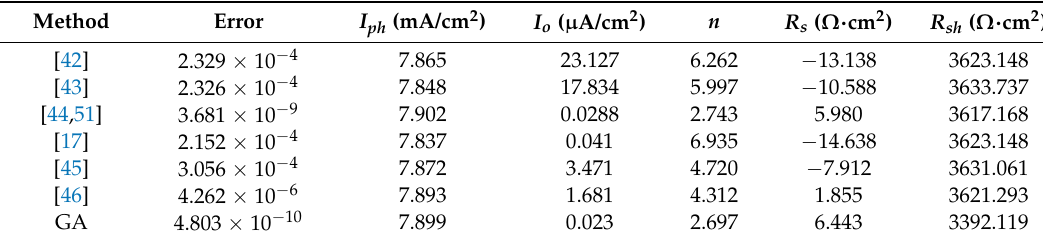
Table 4. One-Diode parameters for cell 1.